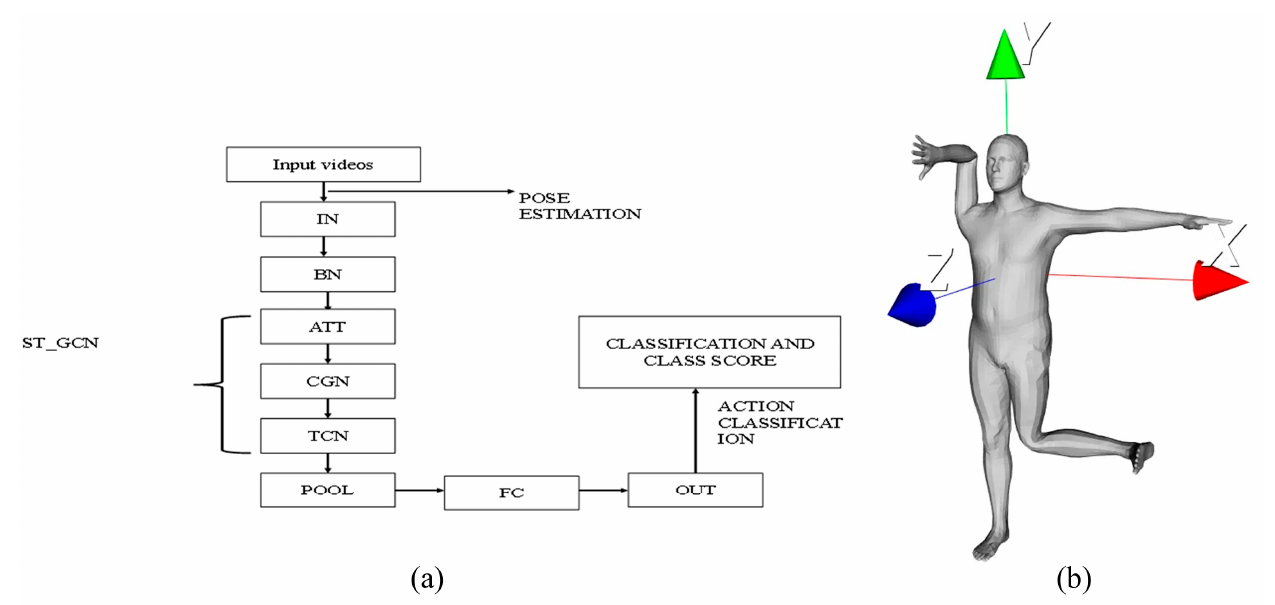
Figure 5. Overall structure diagram of ST-GCN algorithm ( a ); human joint connectivity ( b ).